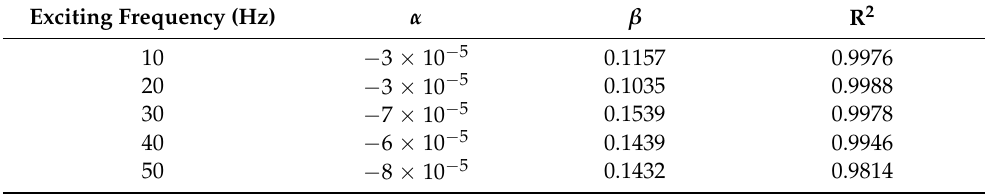
Table 5. Fitting parameters α and β for the confined granular fill at varying excitation frequency. Exciting Frequency